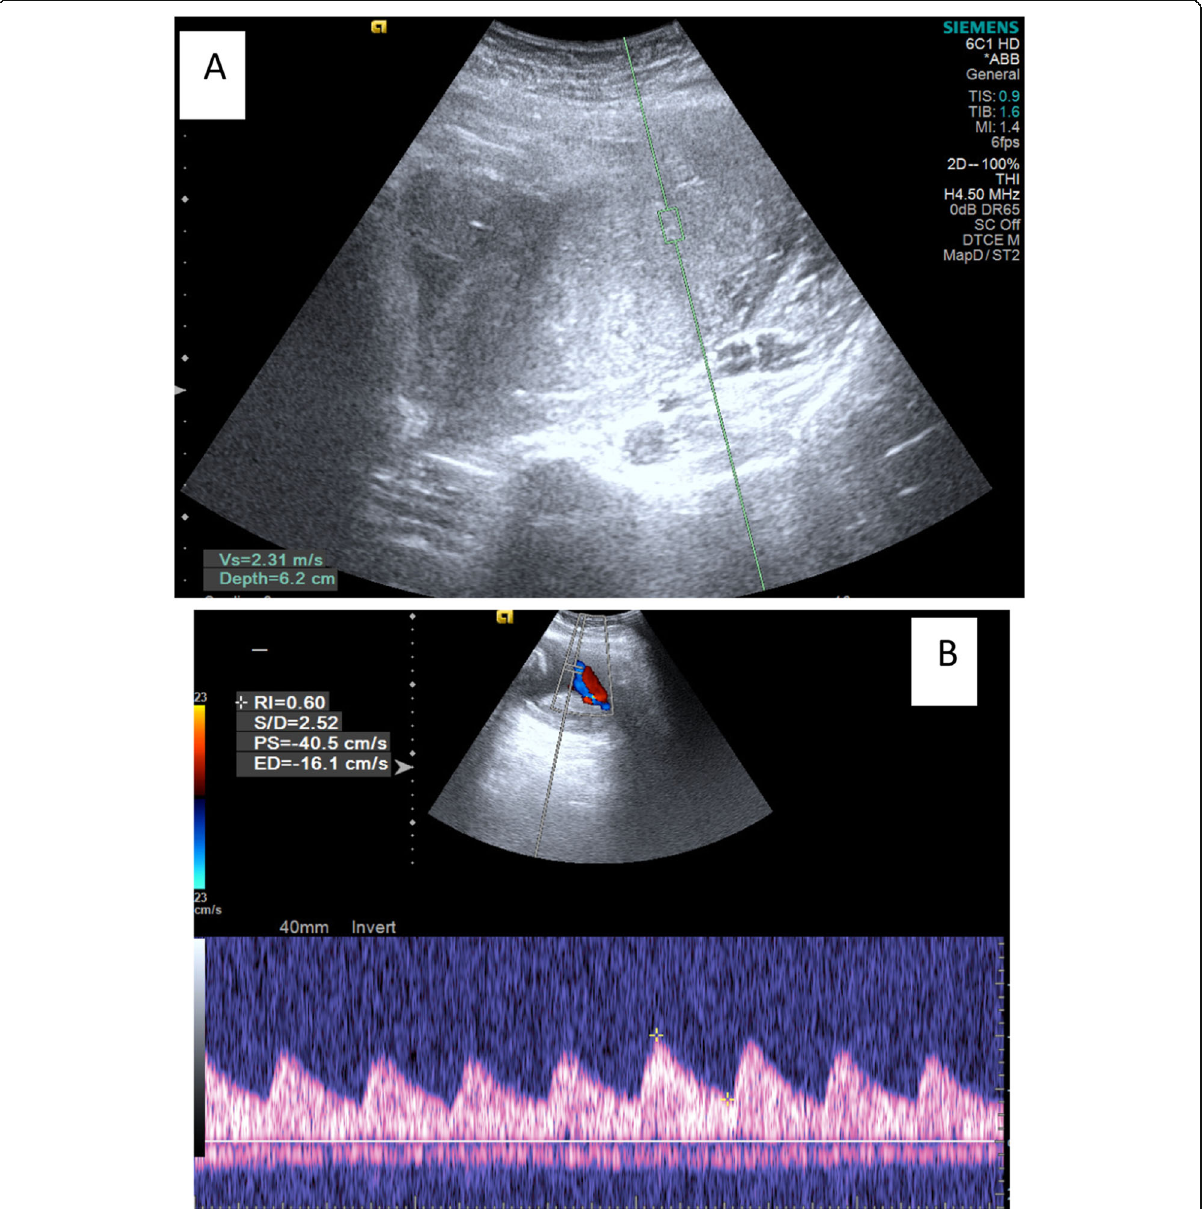
Fig. 3 Pregnancy with preeclampsia, gestational age 33 weeks, and estimated fetal. Weight 1.9 kg. a Grade II posterior placenta with SWV = 2.31 m/s, depth 6.2 cm. b Normal Doppler flow in the umbilical artery with RI 0.6. In the current study, in the placenta of pregnancies complicated by preeclampsia, the SWV was higher than the normal placenta, even with normal Doppler